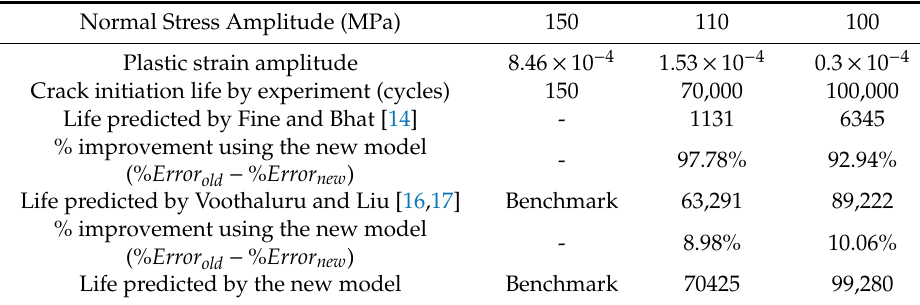
Table 5. Crack initiation life prediction vs. previous